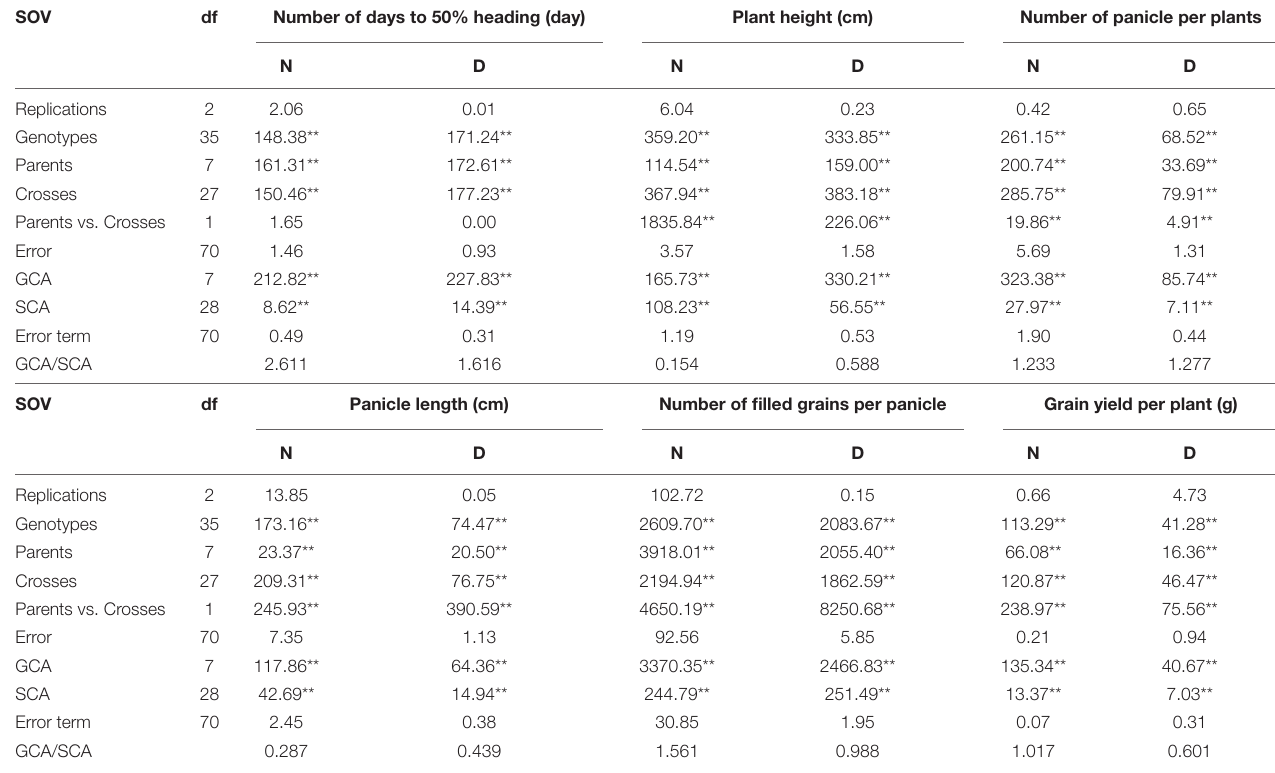
TABLE 3 | Mean square estimates of ordinary analysis and combining ability analysis for yield and related traits under normal and water stress conditions. SOV df Number of days to 50% heading (day) Plant height